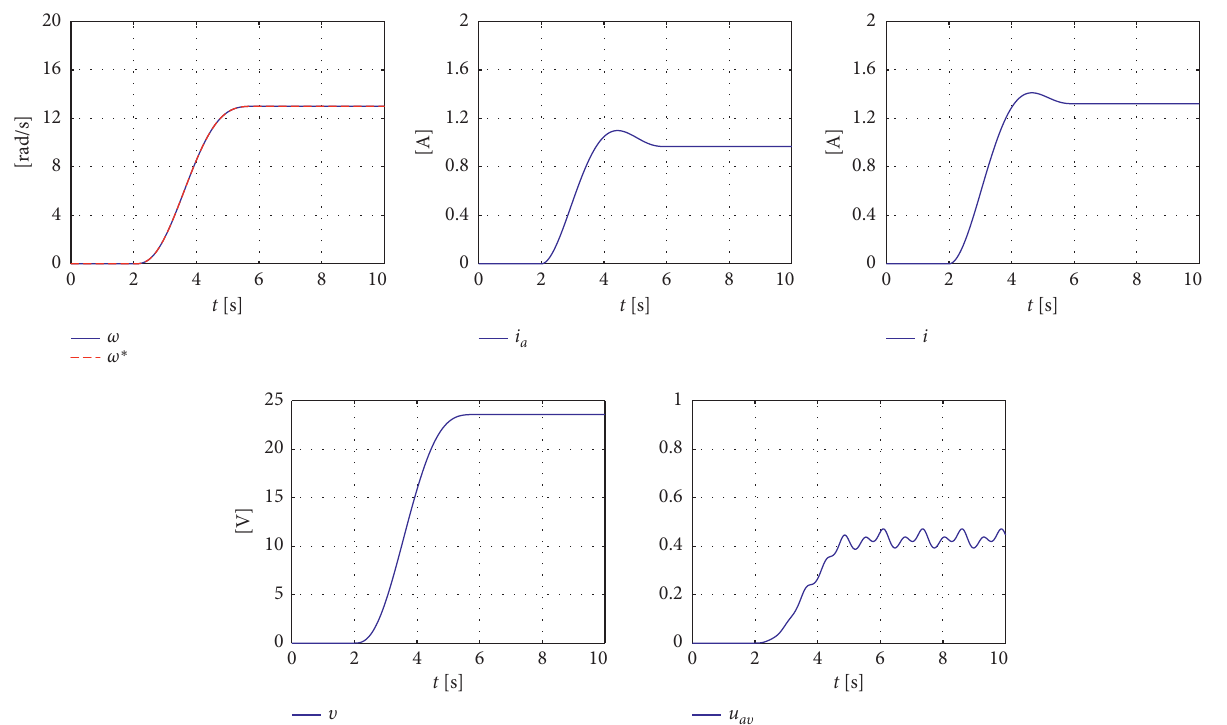
Figure 5: Response of the DC/DC Buck converter-DC motor system when the time-variant waveform and the abrupt variations are defined by equations (17) and (22),